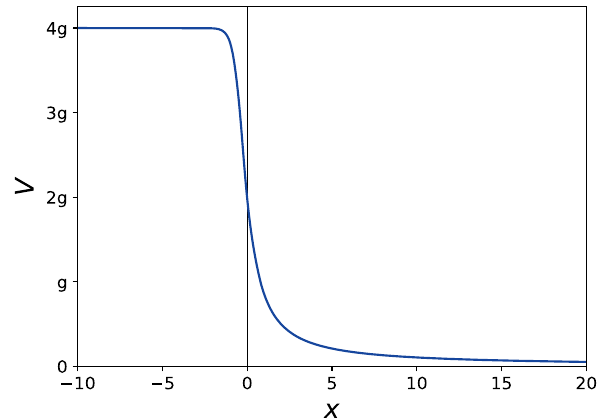
Fig. 4 Potential energy of the Schrödinger-like